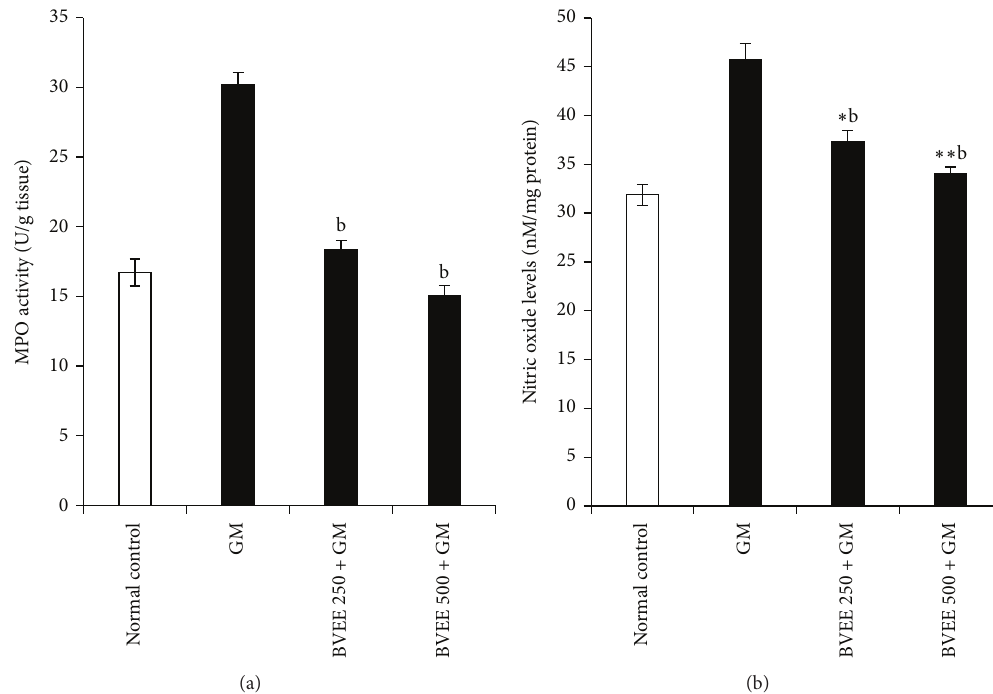
Figure 3: Effect of BVEE on gentamicin-induced changes in inflammatory markers in kidney tissues of rats. (a) Myeloperoxidase (MPO) and (b) nitric oxide (NO). The results are presented as the mean ± SEM of six animals per group. “ ∗ , ∗∗ ” ∗ ∗ ∗ denotes significant differences from the control group ( 𝑃 < 0.05 , 𝑃 < 0.01 , and 𝑃 < 0.001 ); “ a , b , c ” denote significant differences from the GM group ( 𝑃 < 0.05 , 𝑃 < 0.01 , and 𝑃 < 0.001